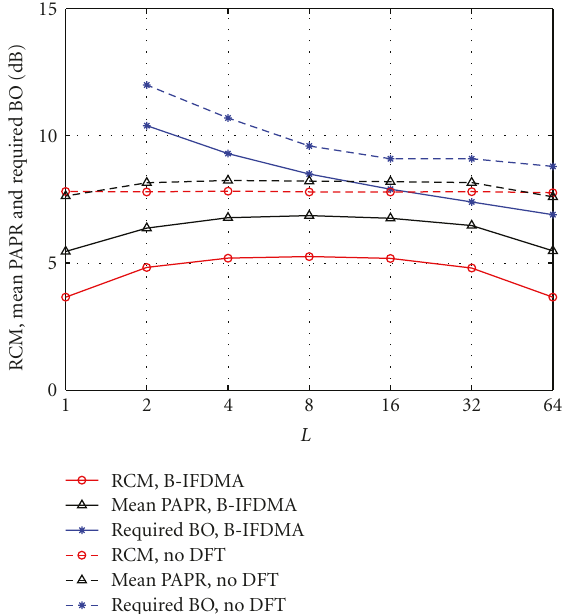
Figure 11: Results for the analysis of the envelope fluctuations of B-IFDMA transmit signals with Q = 64 (with DFT) compared to signals without DFT precoding for di ff erent numbers L of subcarriers per block using di ff erent metrics.